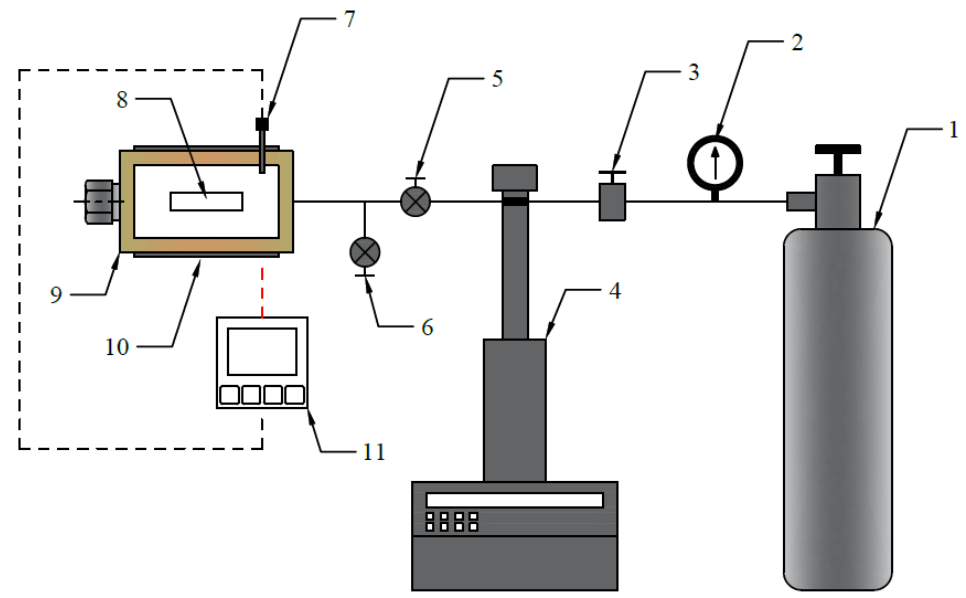
Figure 2. Schematic representation of the batch foaming system: (1) CO 2 cylinder, (2) pressure gauge, (3) refill valve, (4) syringe pump, (5) inlet valve, (6) exhaust valve, (7) thermocouple, (8) sample, (9) chamber, (10) band heater, and (11) temperature controller. Two different temperature profiles were employed to investigate the effect of partial versus complete melting during the gas saturation stage on the foamability of the PP resins, referred to as “Method 1” and “Method 2” (Figure 3). Method 1 is the approach that is